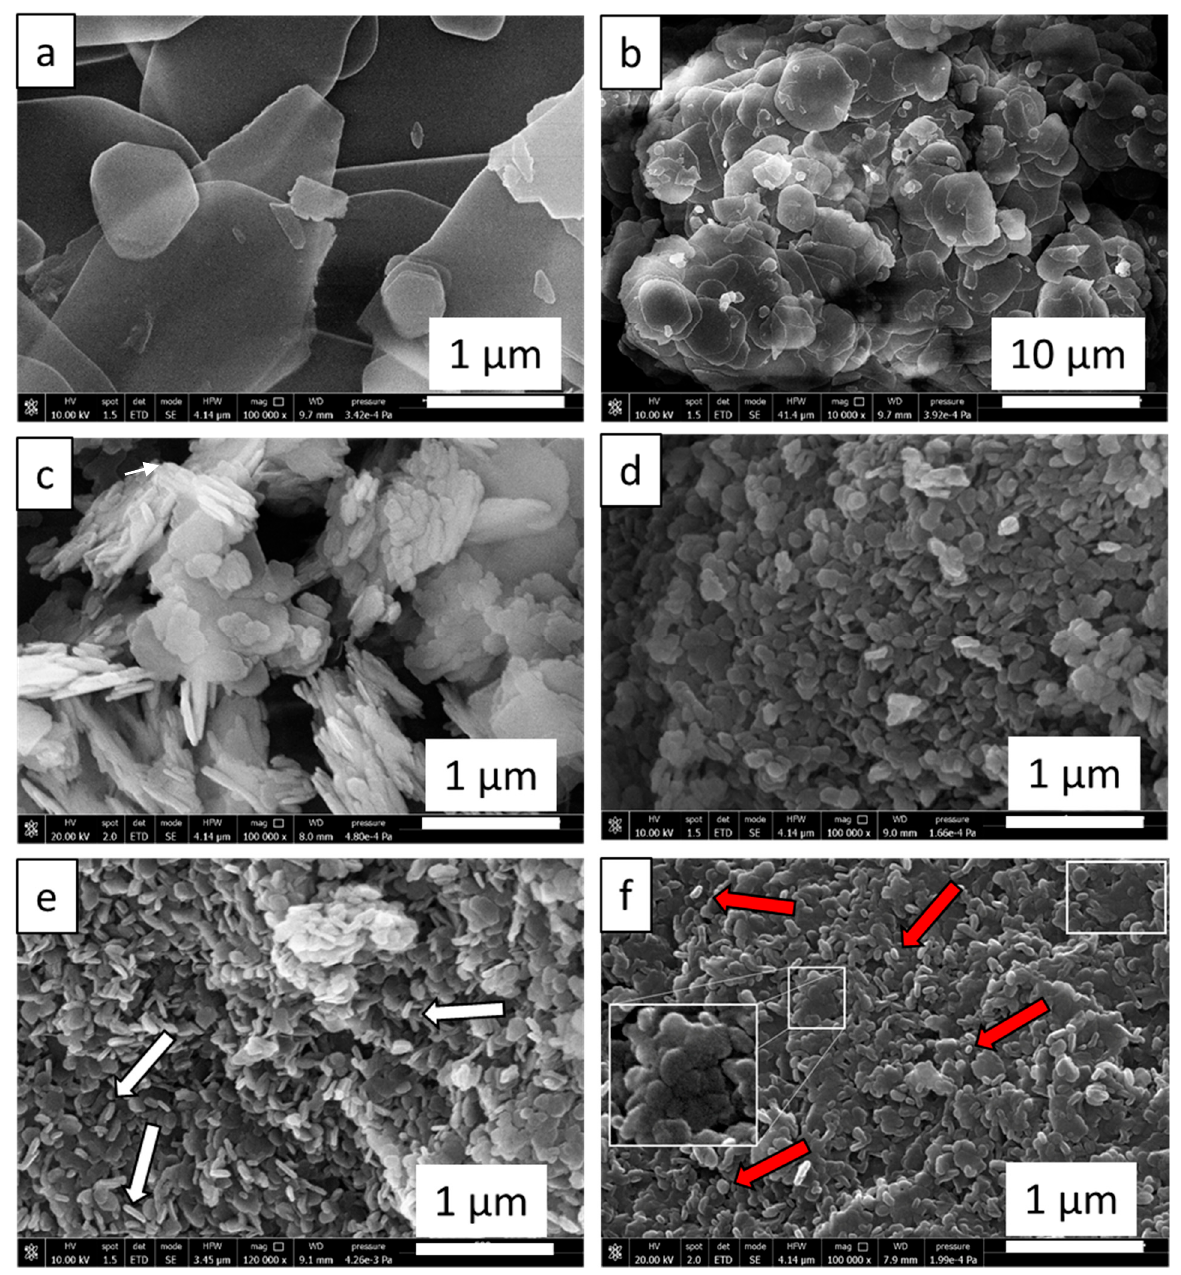
Figure 3. Scanning electron microscope (SEM) images of ( a ) C-MH, ( b ) C-MH at low magnification, ( c ) RDP-MH, ( d ) DP-MH, ( e ) CTAB-DP-MH, ( f ) N-DP-MH samples.